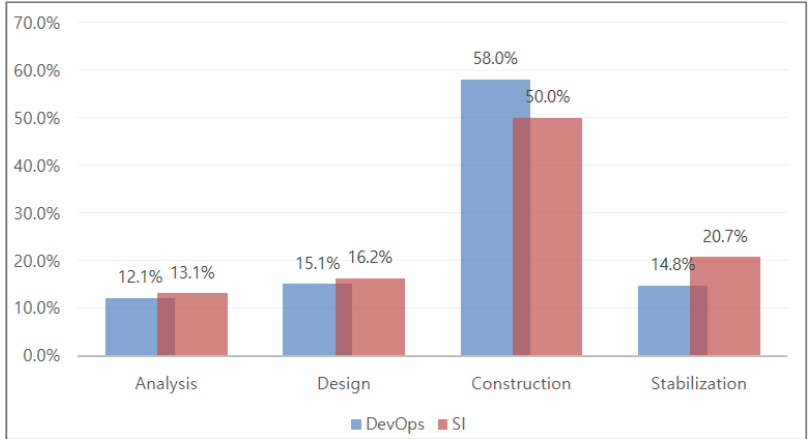
Figure 15. Workforce input in each life cycle.